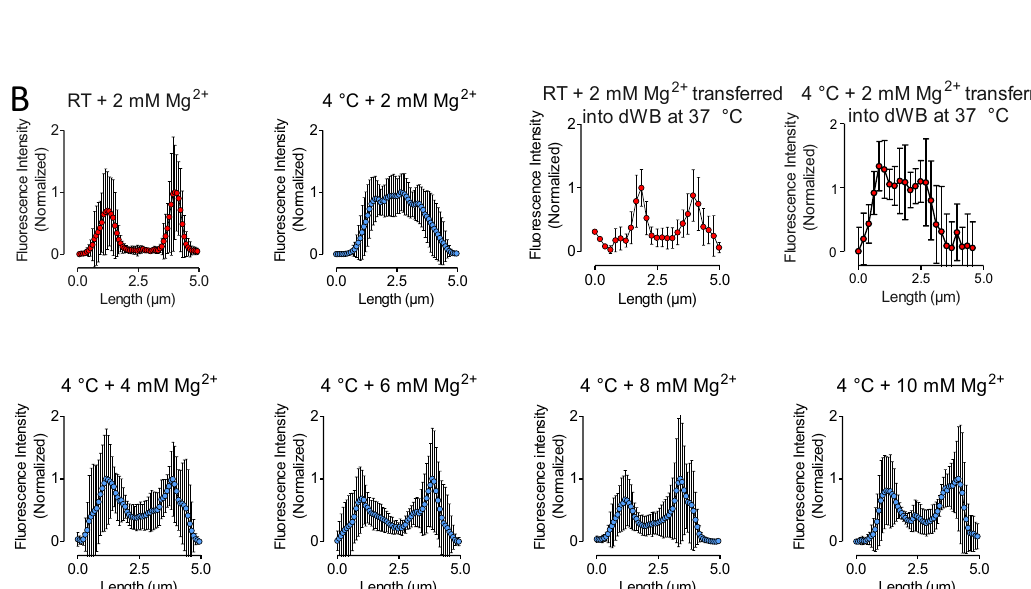
Figure 3. ( A ) Fluorescence image and intensity of stained α-tubulin along an axis of the cross-section of platelets from PC stored at RT or 4 °C. ( B ) Normalized fluorescence intensity of stained α-tubulin along an axis of the cross-section of platelets stored for 24 h under different conditions (n = 10, mean ± standard deviation). α-tubulin was stained by mouse anti-human α-tubulin IgG + secondary donkey anti-mouse IgG Alexa Flour 568. RT room temperature, Mg 2+ magnesium, dWB platelet depleted whole